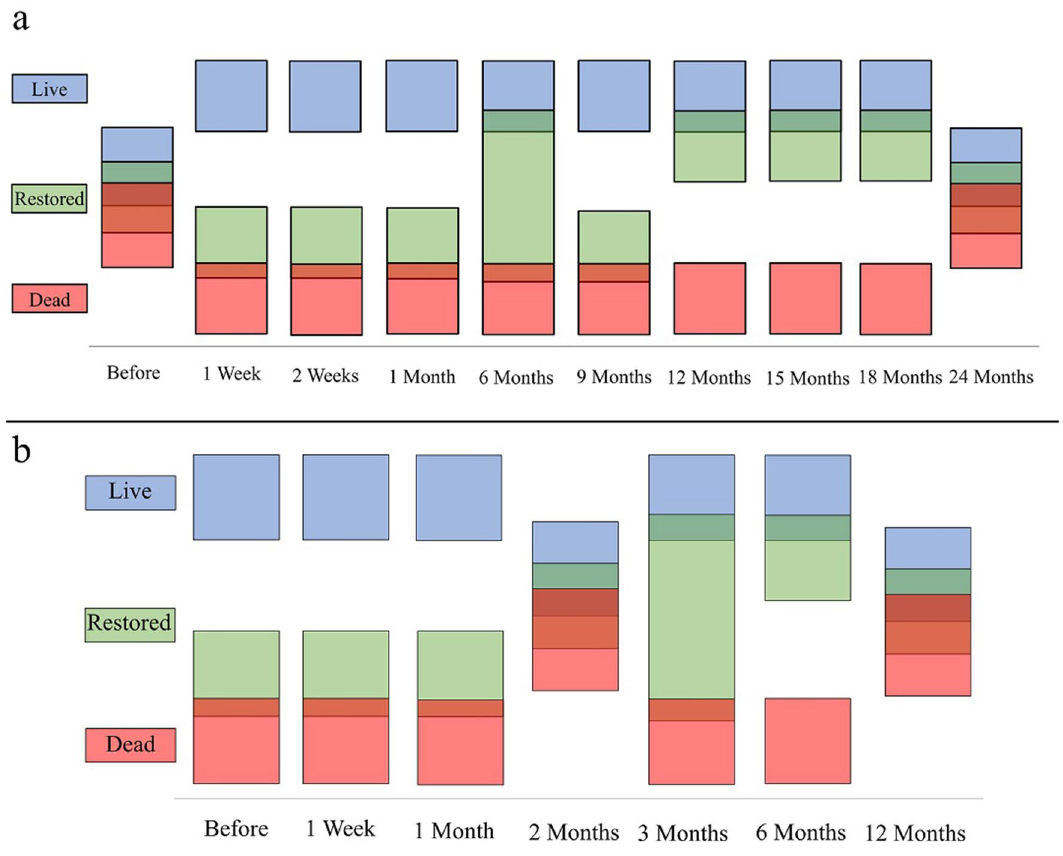
Figure 4. Illustrated results of PERMANOVA pairwise comparisons for 2017 reefs ( a ) and 2018 reefs ( b ). Overlapping squares represent no significant difference between live (blue), restored (green), or dead (red) reefs. Non-overlapping squares represent significant differences between treatments. Statistical significance is based on α = 0.05. Restored reef species composition generally began to reflect that of live reefs approximately 6 months after restoration. All squares overlap before restoration and 24 months after restoration on 2017 reefs and 12 months after restoration on 2018 restored reefs as there were no significant differences in species composition between treatments during these times. The lack of differences during these time periods are likely due to temporal variation in the populations of common crab species collected herein. Despite the lack of